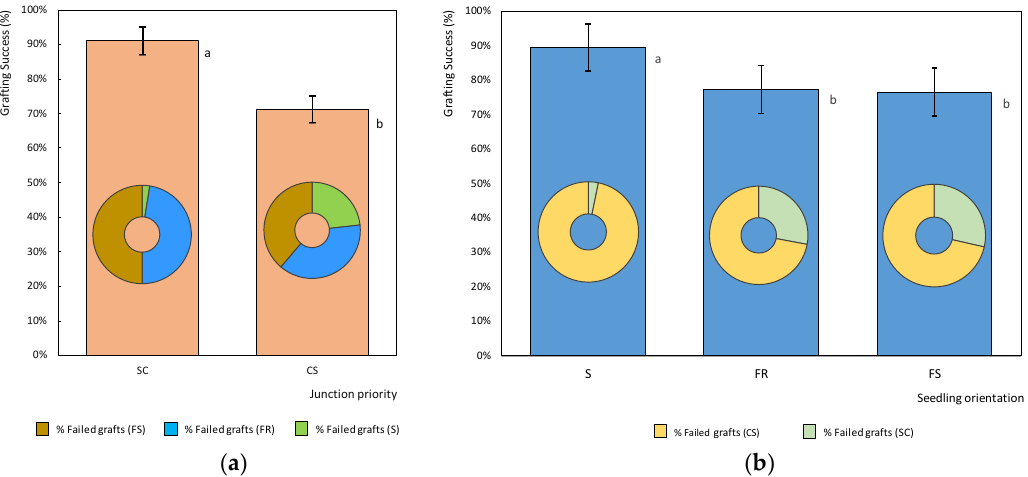
Figure 10. Grouping of information using Tukey’s method with 95% confidence. The success rate includes the typical error. ( a ) Comparison of success for different orders in the graft assembly process. Inside, the ring graphs show the % of failures for each orientation in the junction. ( b ) Comparison between different orientations in the union. Grouping the information using Tukey’s method with 95% confidence. The success rate includes integrated circuits. Inside, the ring graphs shows the % of failures for each order in the junction.